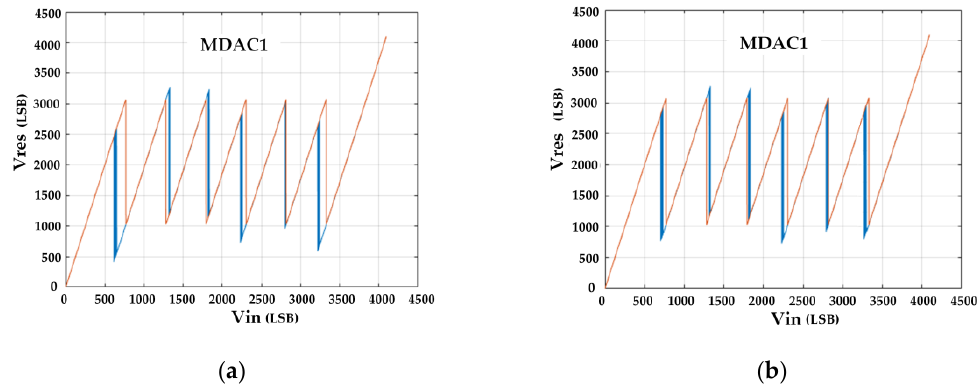
Figure 13. Vres of MDAC1 before and after calibration. Blue line is the ideal Vres, red line is the measured Vres. ( a ) Vres of MDAC1 before calibration; ( b ) Vres of MDAC1 after calibration.